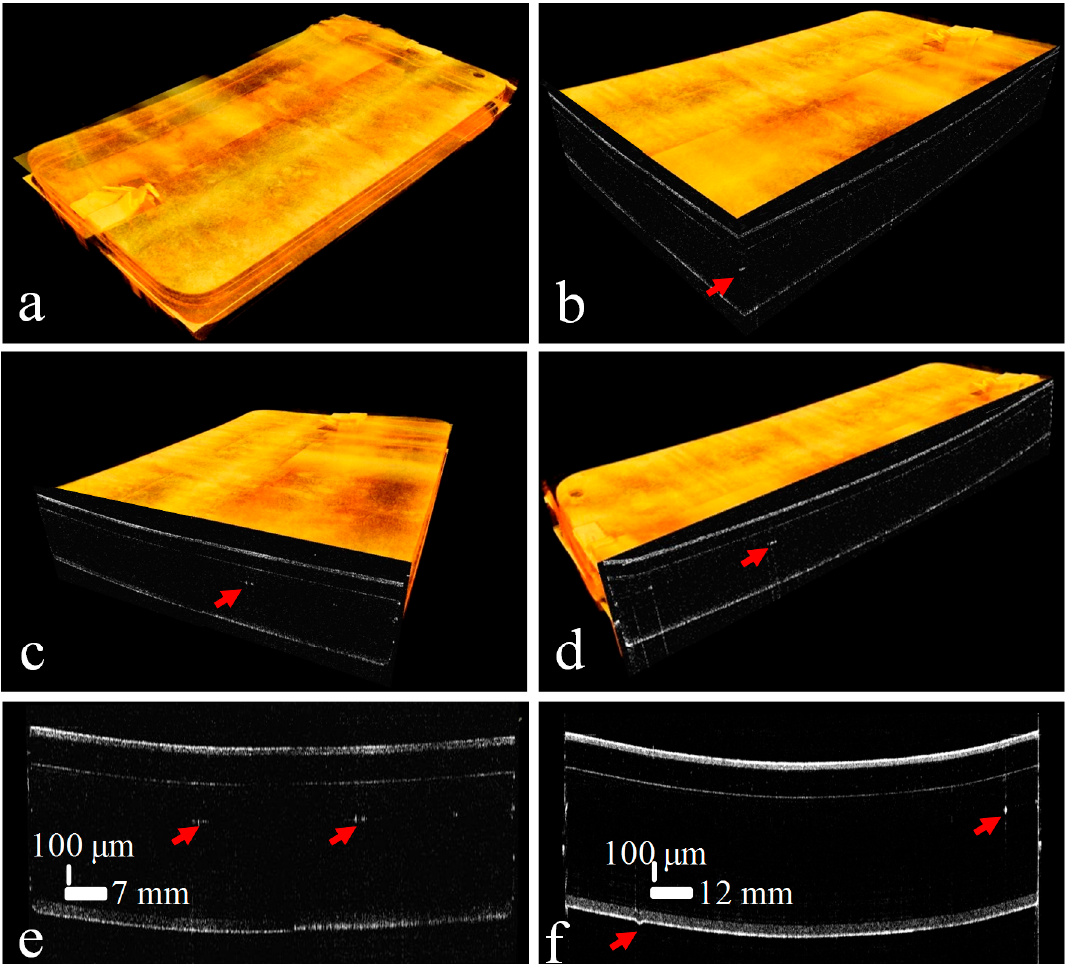
Figure 9. Merged volumetric images from two SD-OCT systems with defects identified with red arrows: ( a ) volumetric image of complete thin film panel scanned by two scanning heads simultaneously; ( b ) the ortho-sliced view of the volumetric image; ( c ) the ortho-sliced cross-sectional view along the transverse fast-scanning direction of two sample heads; ( d ) the ortho-sliced cross-sectional view along the motorized lateral slow-scanning direction; ( e ) merged cross-sectional image by two sample heads; and ( f ) cross-sectional image along lateral slow-scanning direction.